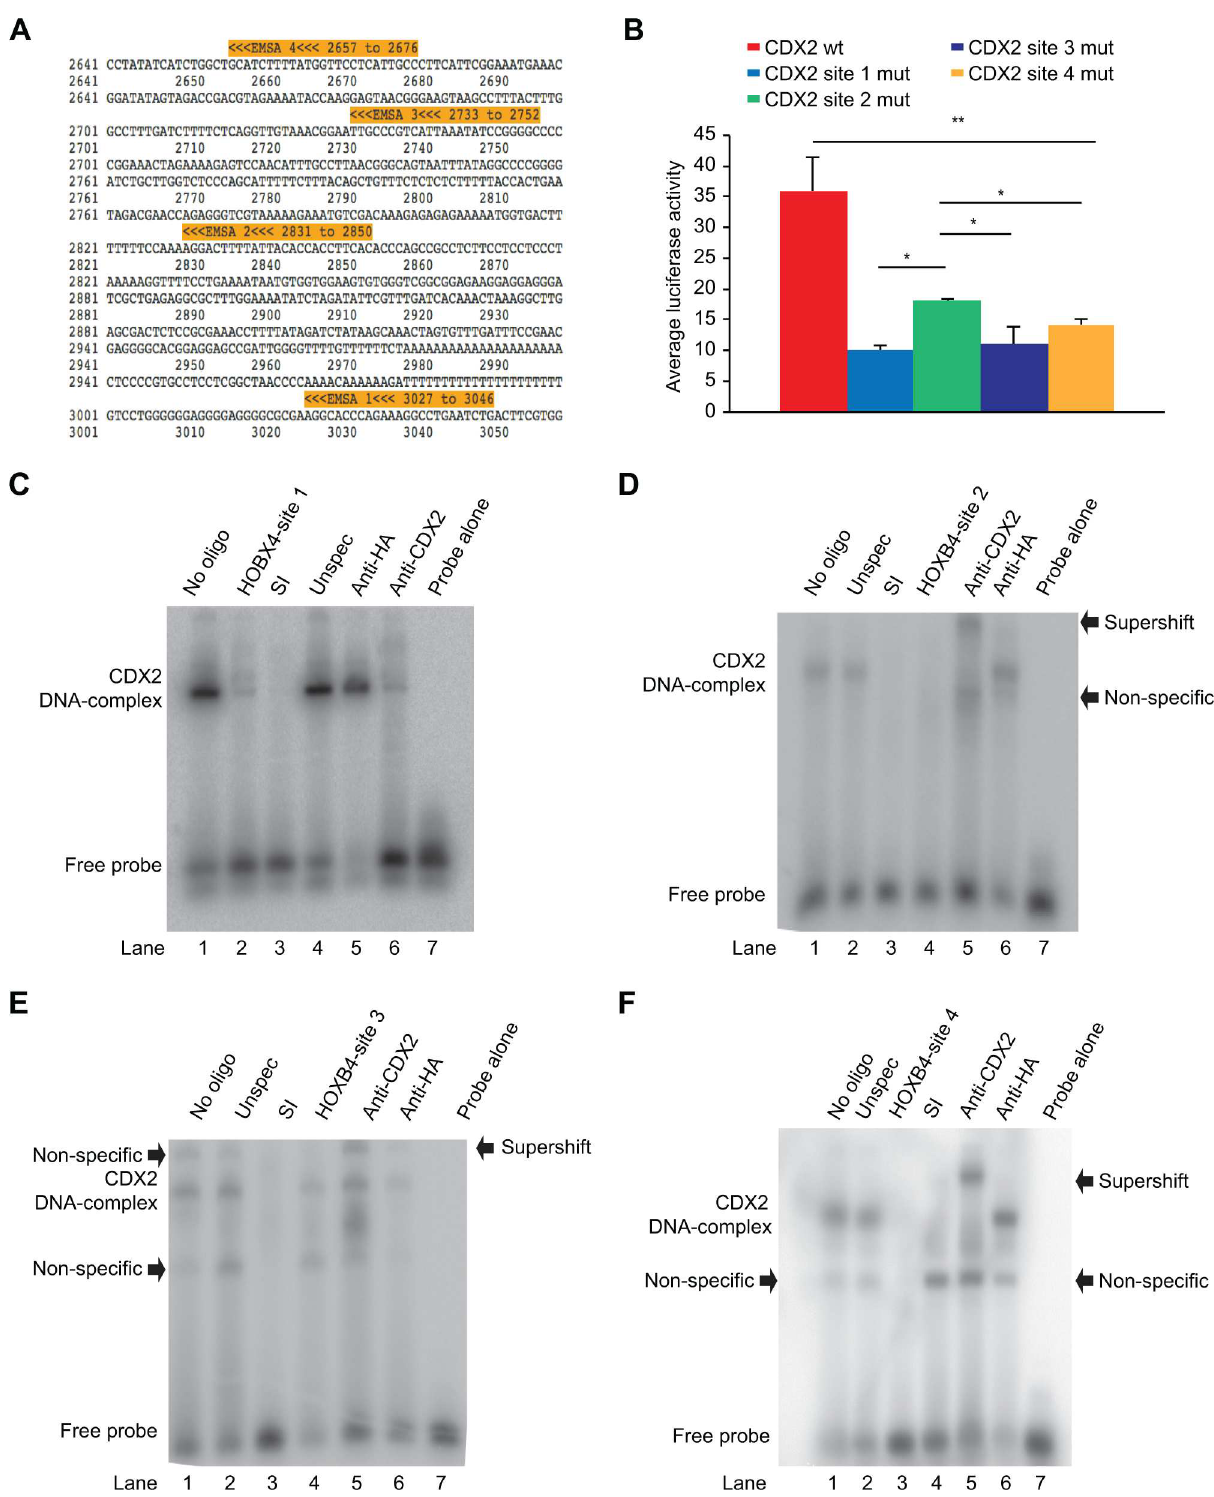
Fig 3. Functional and EMSA analyses of CDX2 binding sites in the HOXB4 enhancer region. Fig 3A) Positions of the four potential CDX2 bindingsites and the EMSA probes covering these sites. Fig 3B) Reporter gene assays with four different luciferaseconstructs containingthe HOXB4 enhancerwith wild-type CDX2 bindingsites or four distinct reporter constructs containing individualmutations in the four CDX2 bindingsites ( HOXB4 site-1, -2, -3 or 4). The mean (n = 4) and SD are shown. * P < 0.05 and ** P < 0.01. Fig 3C–3F) EMSAs